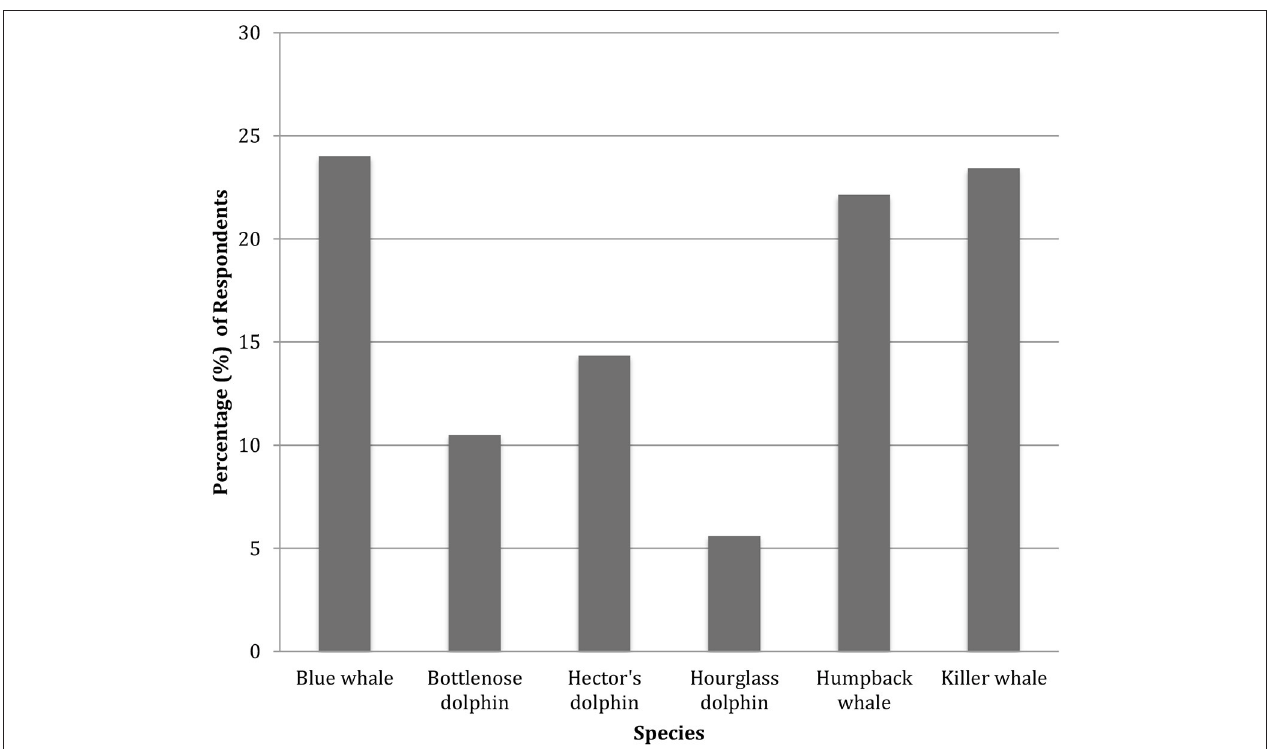
FIGURE 8 | Which dolphin/whale species listed respondents felt was the most endangered ( n = 858).